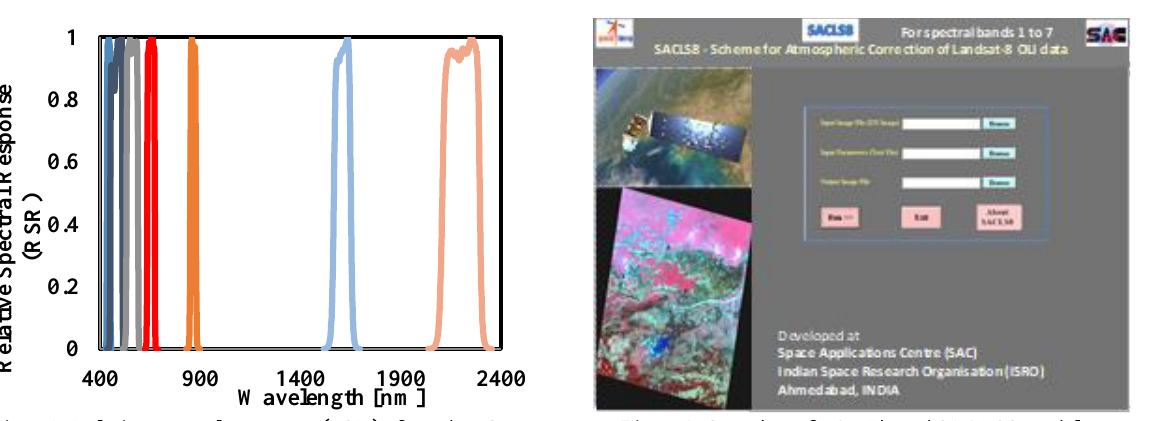
Figure1: Relative spectral responses (RSR) of Landsat-8 OLI sensors.